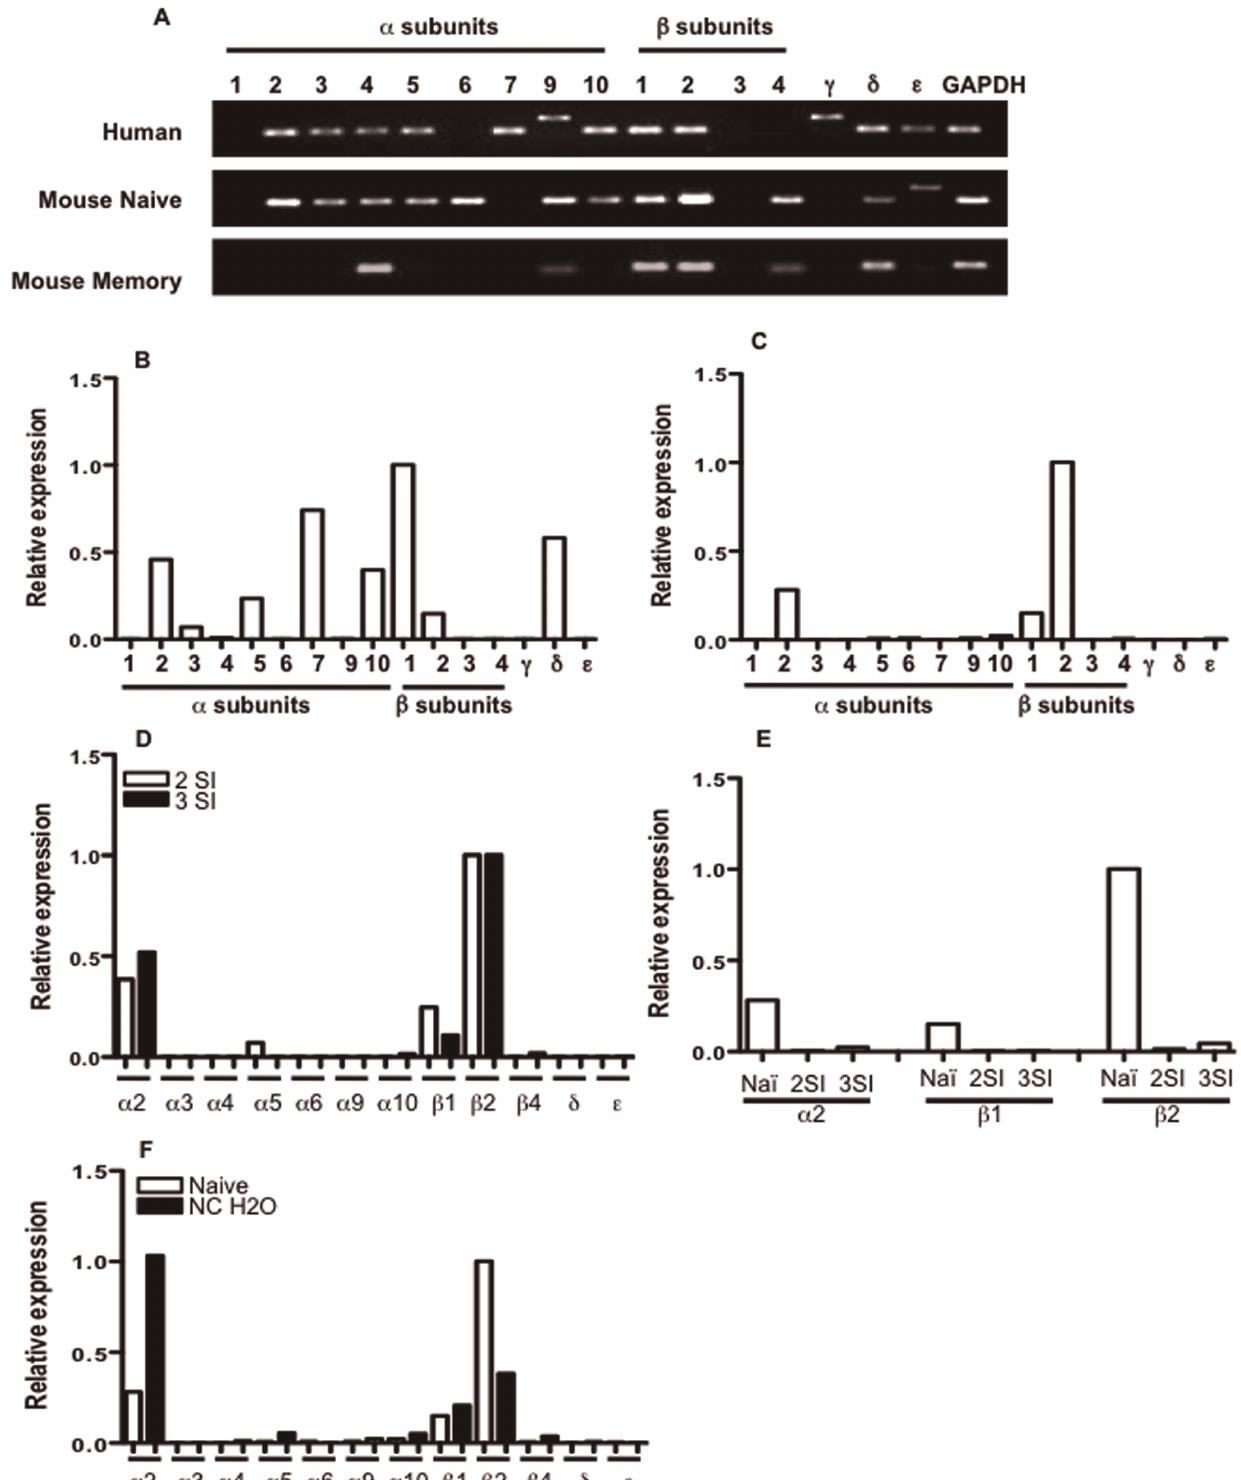
Figure 1. Expression of nAChRs in CTLs from human and mice. Purified RNA from human and mouse CD8 T cells were examined for nAChR subunits using PCR. A. PCR results (40 cycles, all PCR products were confirmed by sequencing). Memory OT-I cells were obtained as described in the text and as previously reported [35,83]. B–C. Quantitative PCR was performed on RNA from human CD8 T cells (B) or murine naive CD8 T cells (C). Expression of all subunits was relative to b 2 (the highest expression) in murine naı¨ve CTLs (C), which was designated as 1. D. Purified naı¨ve OT-I cells were stimulated with 2SI or 3SI (2SI plus IL-12) for 3 days, and expression of nAChRs was compared relatively to b 2 in each treatment (2SI and 3SI). E. The expression of 3 dominant nAChR subunits in 2SI and 3SI treatments was compared to naı¨ve OT-I using the housekeeping gene GAPDH as internal